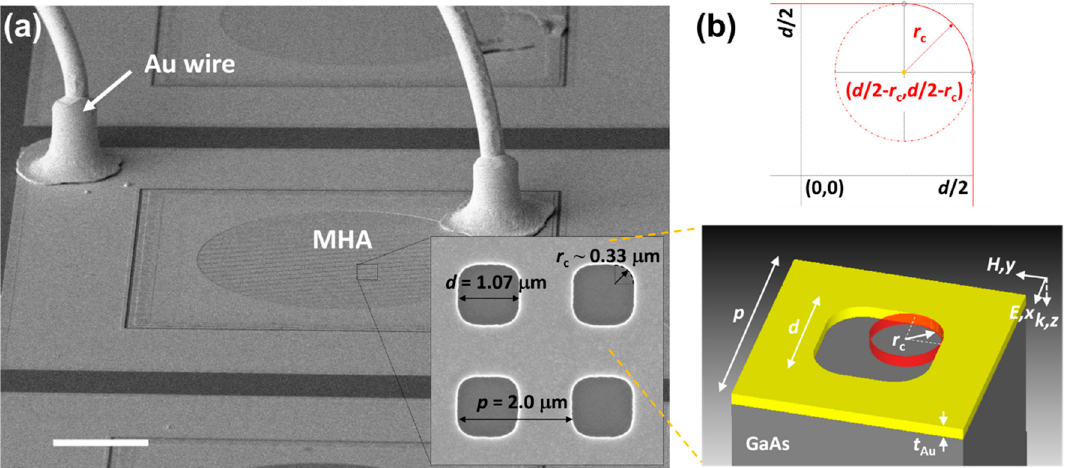
Figure2. ( a )20 ◦ tiltedSEMimageofmetalholearray(MHA)-layeredDWELLpixeldetector. Insetshows Figure 2. ( a ) 20  tilted SEM image of metal hole array (MHA) ‐ layered DWELL pixel detector. Inset the magnified square holes with rounded corners: p = 2.0 µ m, d = 1.07 µ m, and r c = ~0.33 µ m. Scale bar shows the magnified square holes with rounded corners: p = 2.0 μ m, d = 1.07 μ m, and r c = ~0.33 μ m. is 100 µ m; ( b ) schematic illustration and geometrical parameters of MHA / GaAs unit cell with r c . Here, Scale bar is 100 μ m; ( b ) schematic illustration and geometrical parameters of MHA/GaAs unit cell two extreme cases for the corner-shape radius r c are r c = 0 µ m for a square-shaped hole and r c ~ 0.54 µ m with r c . Here, two extreme cases for the corner ‐ shape radius r c are r c = 0 μ m for a square ‐ shaped hole ( r c / d = 0.5) for a circle-shaped hole. In addition, the configuration of polarization ( E // x ) and propagation and r c ~ 0.54 μ m ( r c / d = 0.5) for a circle ‐ shaped hole. In addition, the configuration of polarization ( E // x ) ( k // z ) are and propagation ( k // z ) are depicted.